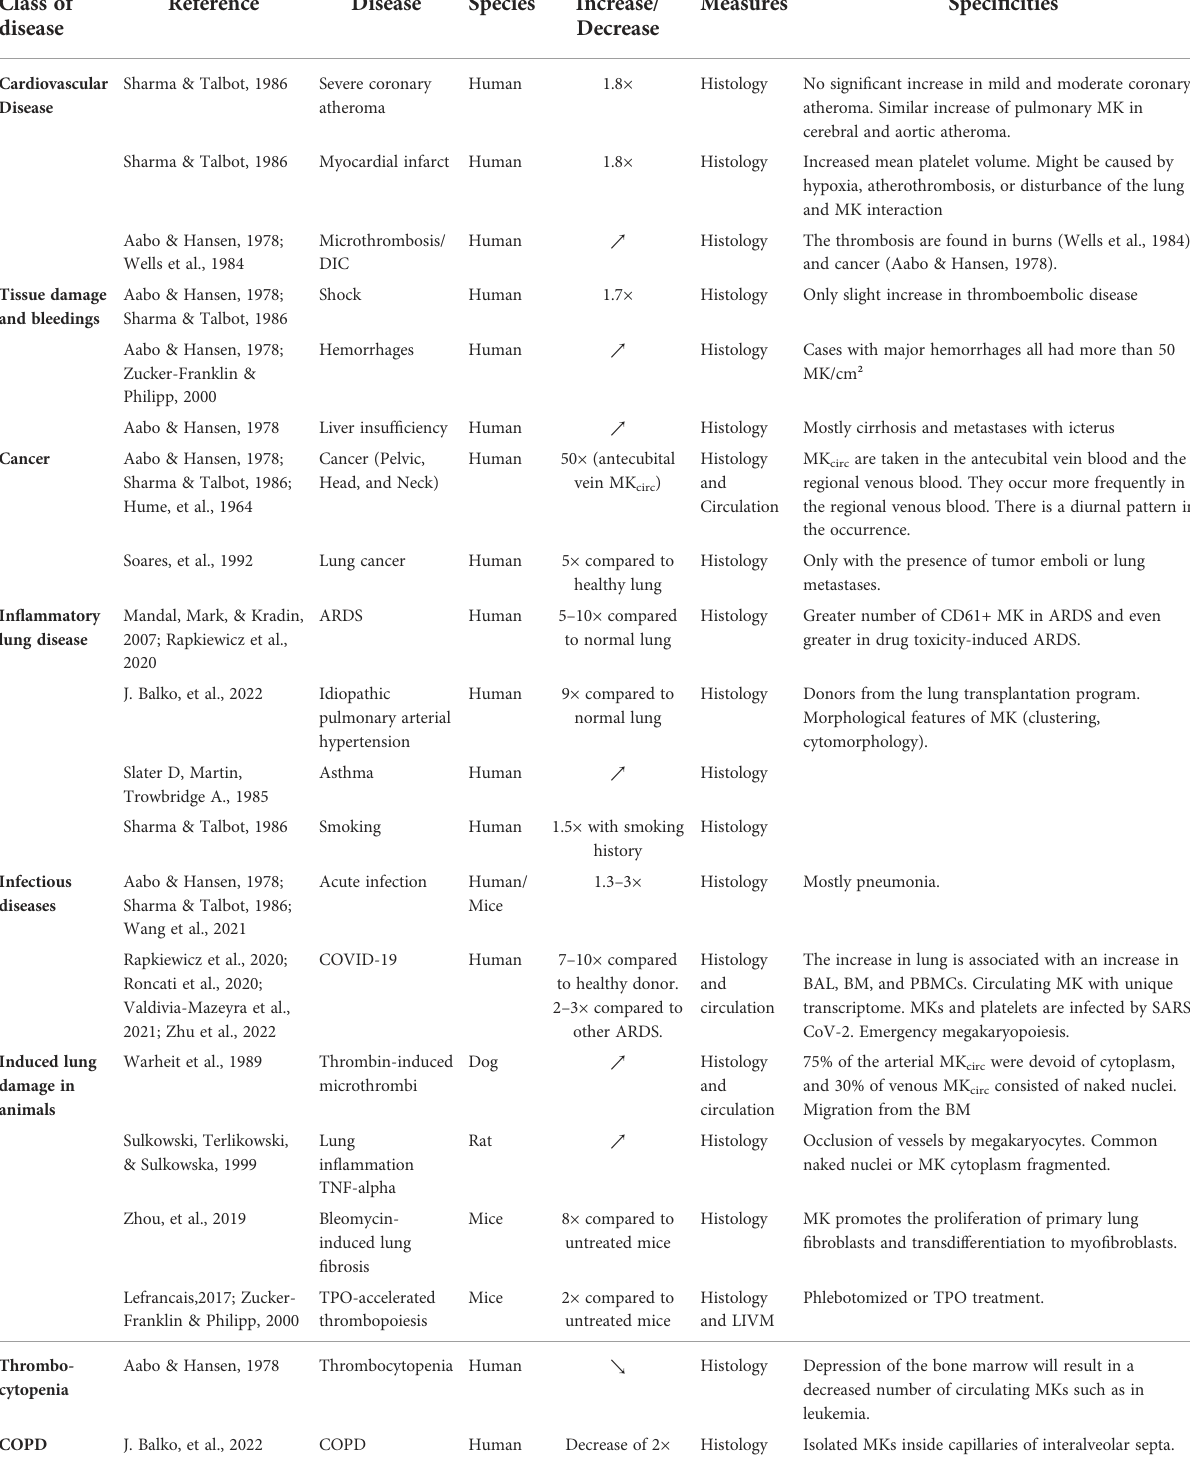
TABLE 1 Increased and decreased occurrence of lung megakaryocytes with